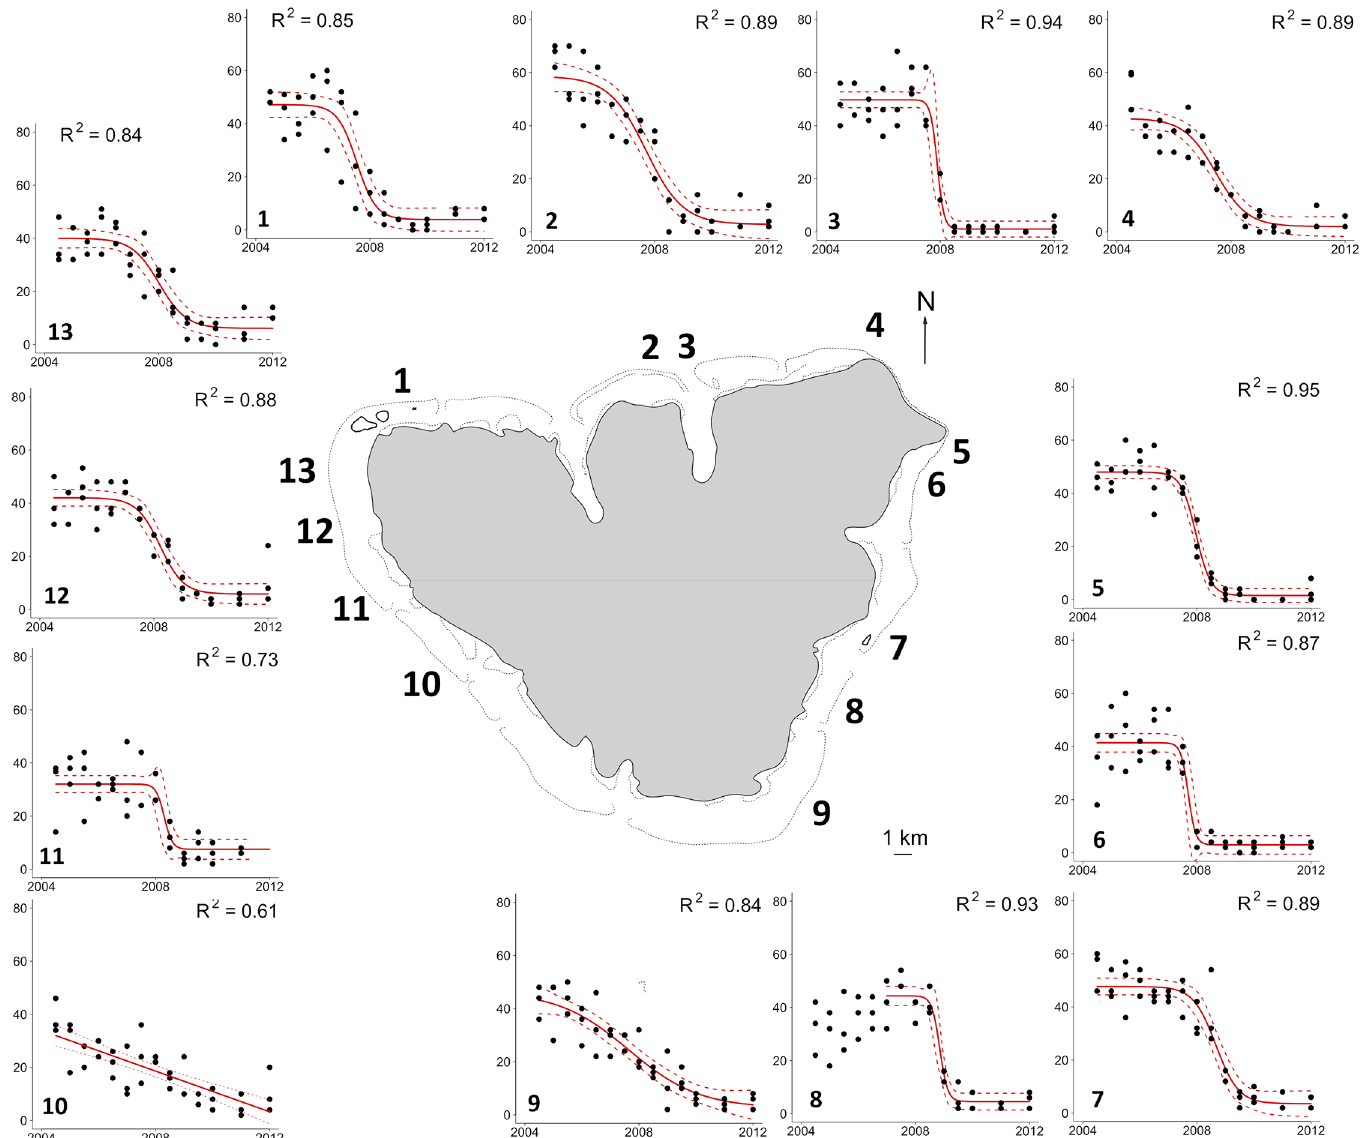
Fig 1. Map of the 13 reefs surveyed from 2004 to 2012 on Moorea Island. Reefs are labelled from 1 to 13 according to their locations. The graphs surrounding the island represent the temporal dynamics in coral cover (in percent) on the corresponding reefs. For each reef, black points represent indiviudal observations; red lines correspond to the fitted logistic models (with the exception of reef 10 for which the temporal dynamic is better represented using a linear model) with their corresponding 95% confidence intervals. R 2 is the coefficient of determination.